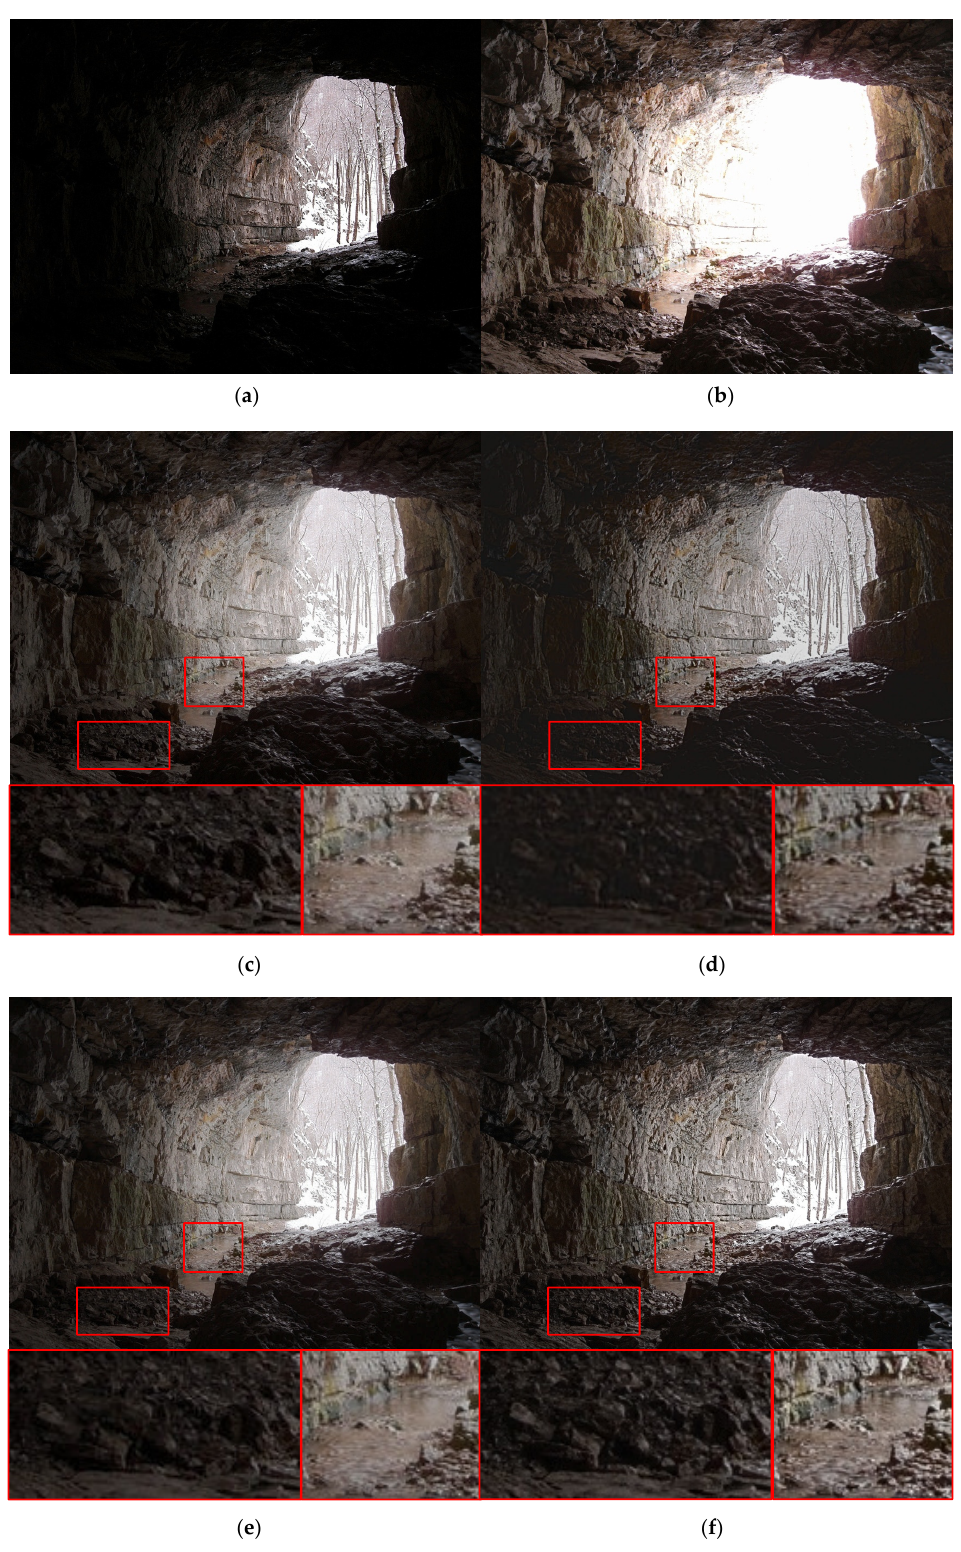
Figure 14. Input and result images (4): ( a ) Under-exposed image, ( b ) Over-exposed image, ( c ) DenseFuse, ( d ) U2Fusion, ( e ) TransMEF, ( f ) Proposed model.